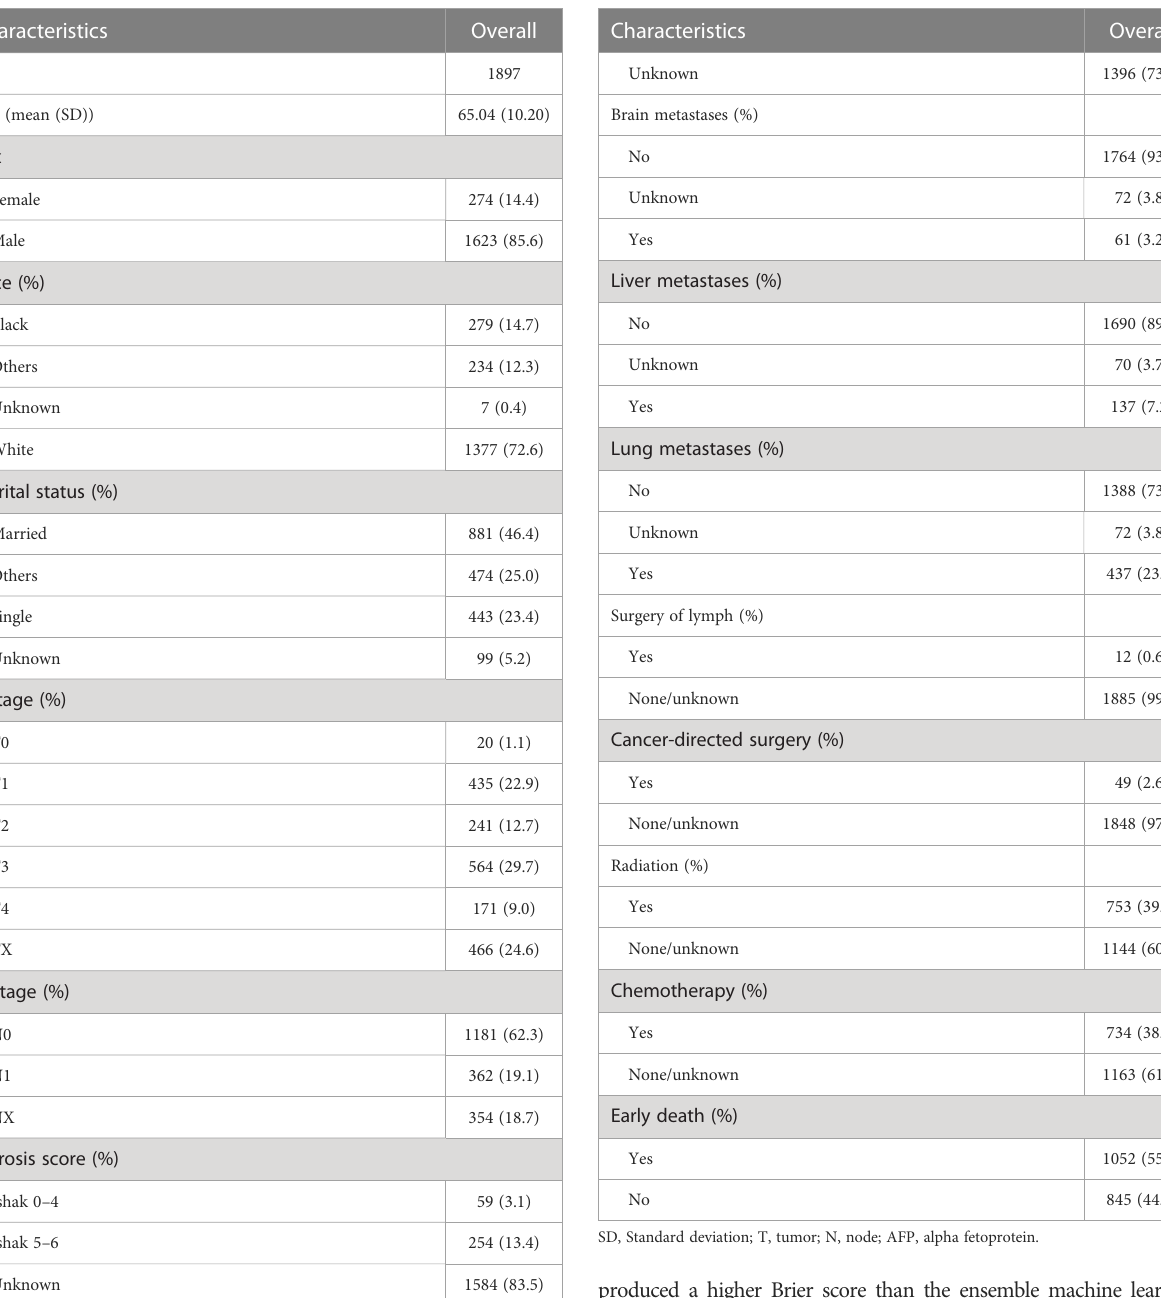
produced a higher Brier score than the ensemble machine learning model, indicating a bigger prediction error. Table 5 summarizes additional indicators in greater detail. Calibration plots are displayed in Figures 4, 5 shows the decision curve for each model in the study, showing that models, in particular the ensemble machine learning model, had good clinical usefulness. The calibration plot of the ensemble model in the external validation is shown in Supplementary Figure 5. It showed the calibration curve was not close to the ideal reference line, although the calibration slope was near to 1. To further improve the calibration of the ensemble model, we revised the model via subtracting 20.0% in each predicted risk of early mortality. Thus, the new revised calibration plot was provided (Supplementary Figure 6), and it demonstrated that the calibration